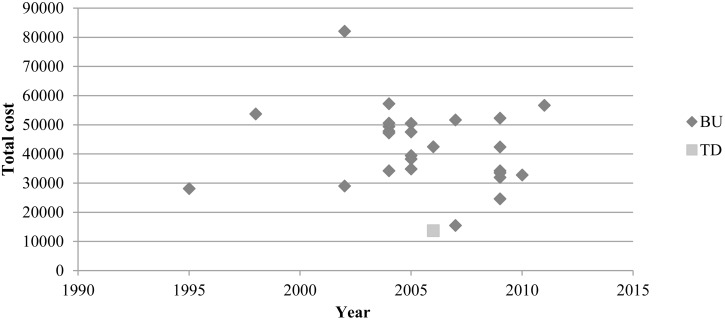
Cost per patient and year, discounted at 1% until 2011.